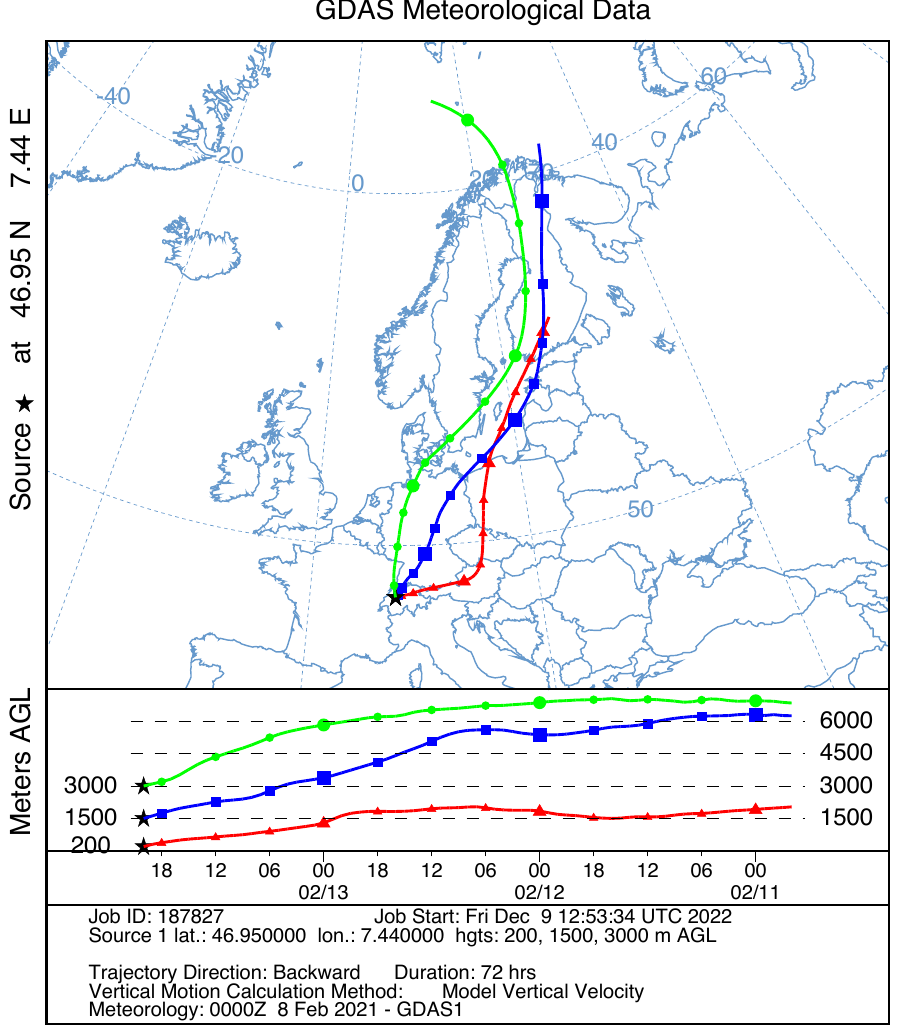
Figure 7. Three day back trajectories of air masses which arrived on 13 February 2021 20:00 UT in Bern. The computation and the plot are provided by the NOAA HYSPLIT webpage